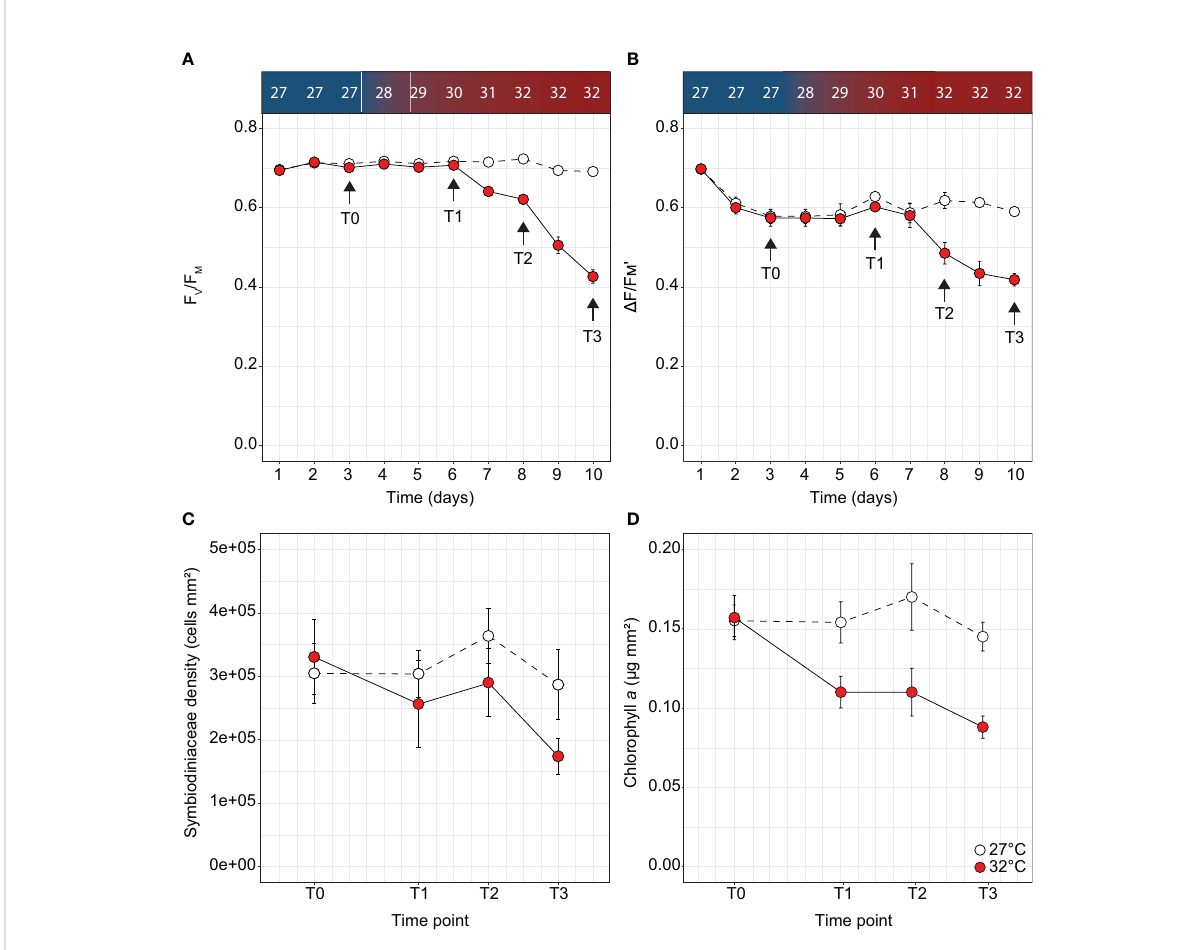
FIGURE 1 Physiological parameters measured over time for Acropora millepora under thermal stress including (A) maximum quantum yield of photosystem II (F V /F M ), (B) effective quantum yield of photosystem II ( D F/F M '), (C) Symbiodiniaceae density and (D) chlorophyll a for the control (white circles) and treatments (red circles). Letters indicate signi fi cant differences between timepoints for the treatment. Temperature increases indicated along the top panel for corresponding days and sampling timepoints. Averages (± SE) are shown (n =